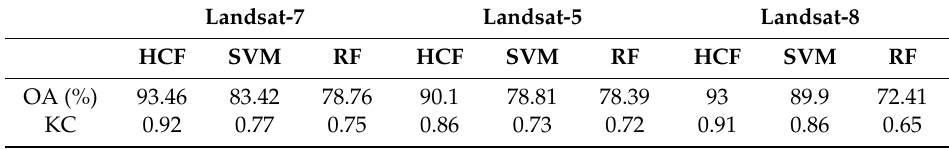
Figure 5. The comparison of PA and UA between HCF, SVM and RF on Yancheng coastal wetland.